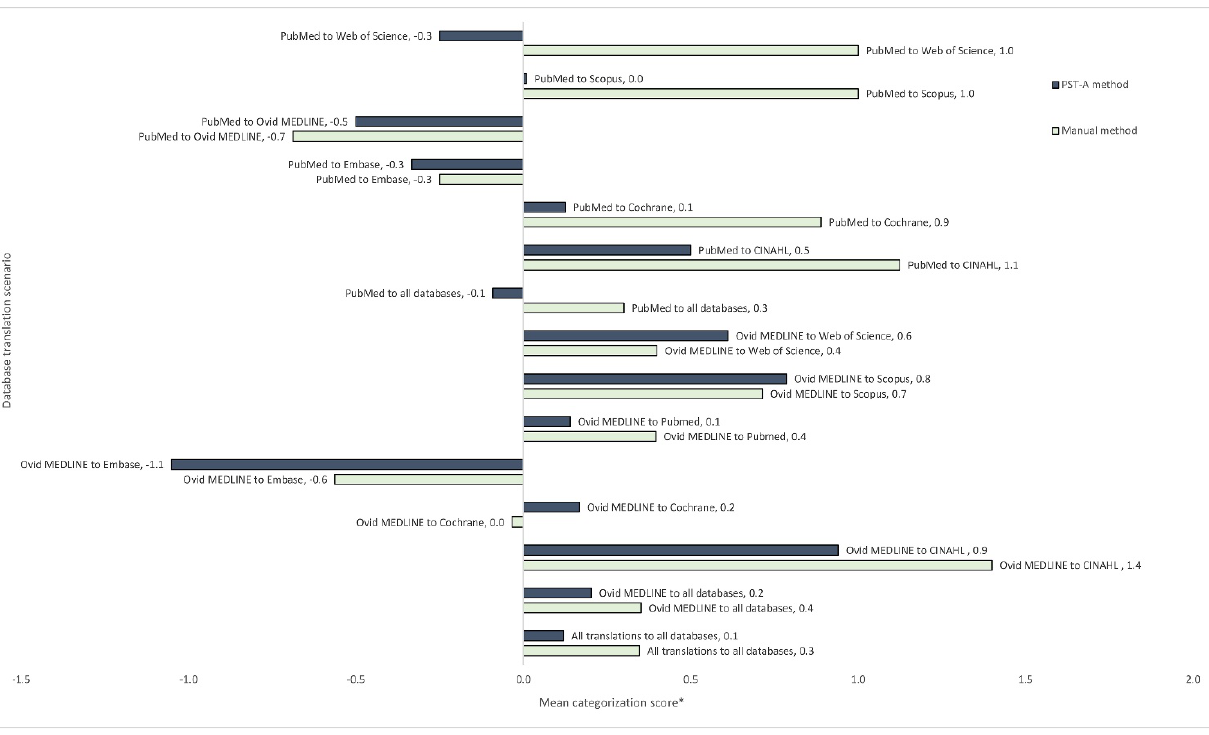
Figure 3 Mean categorization score for the number of references retrieved by translated search strings compared to the reference standard